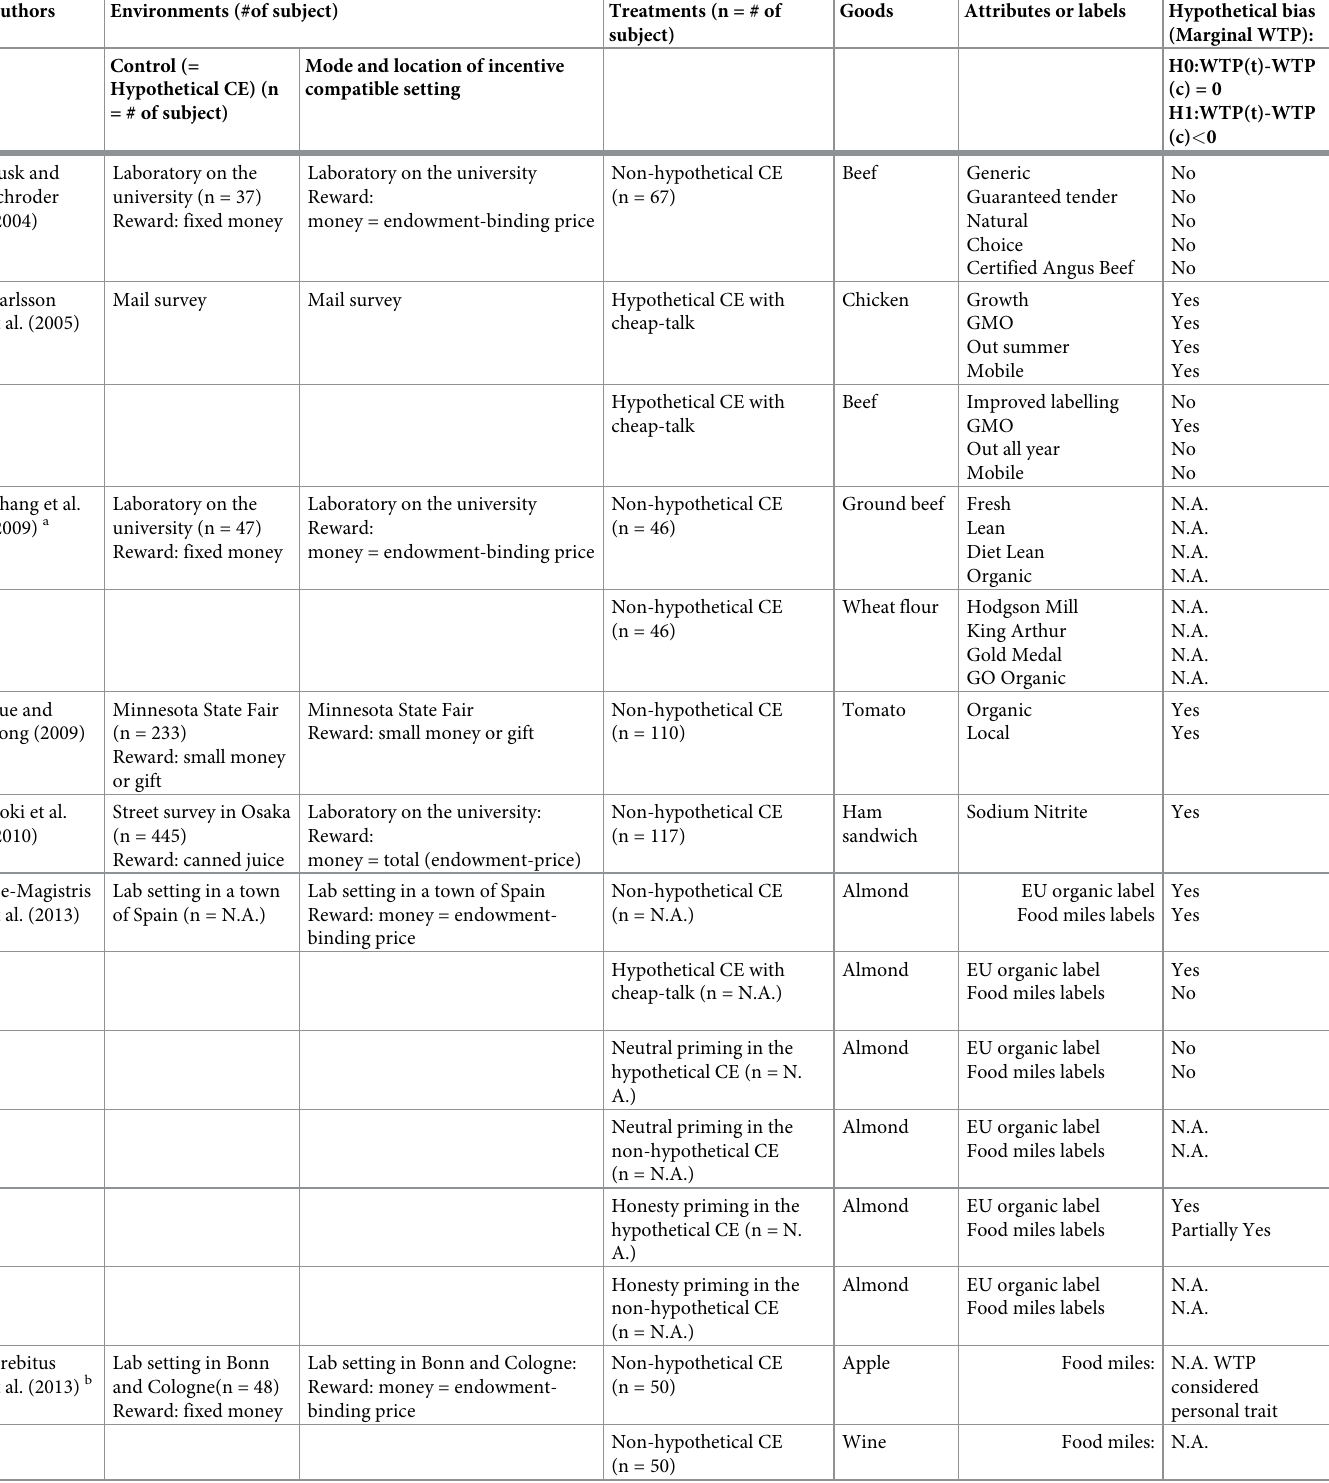
Table 1. Summary of previous studies on testing hypothetical bias by employing